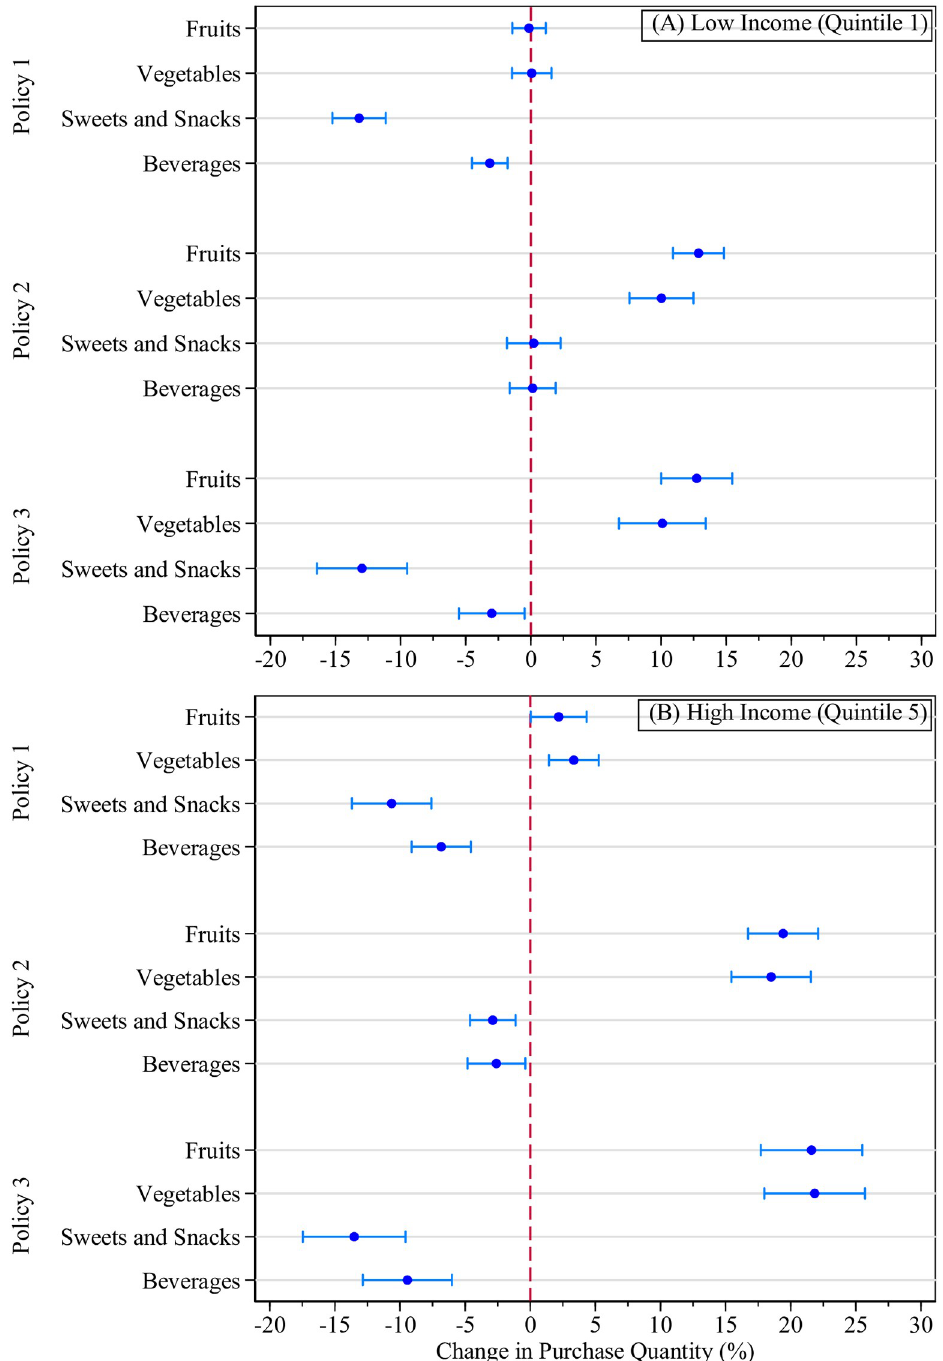
Fig 2. Average percentage change in household purchases (%), by household income. Notes: Results are shown only for food/beverage groups targeted by taxes or subsidies. All point estimates are accompanied by a 95% confidence interval calculated using bootstrapped standard